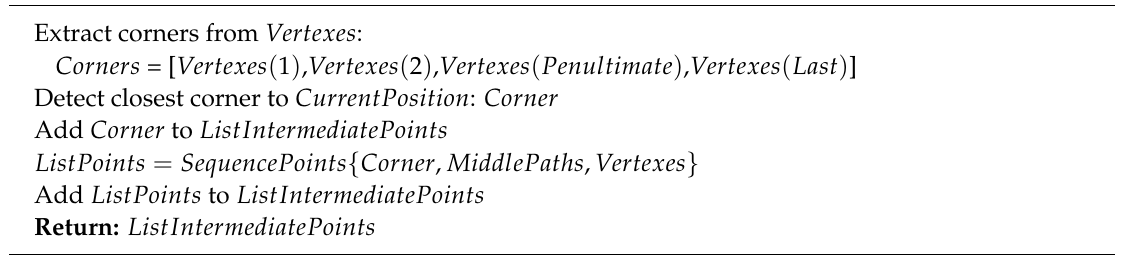
Algorithm 9 IntermediatePoints{ Position , MiddlePaths , Vertexes